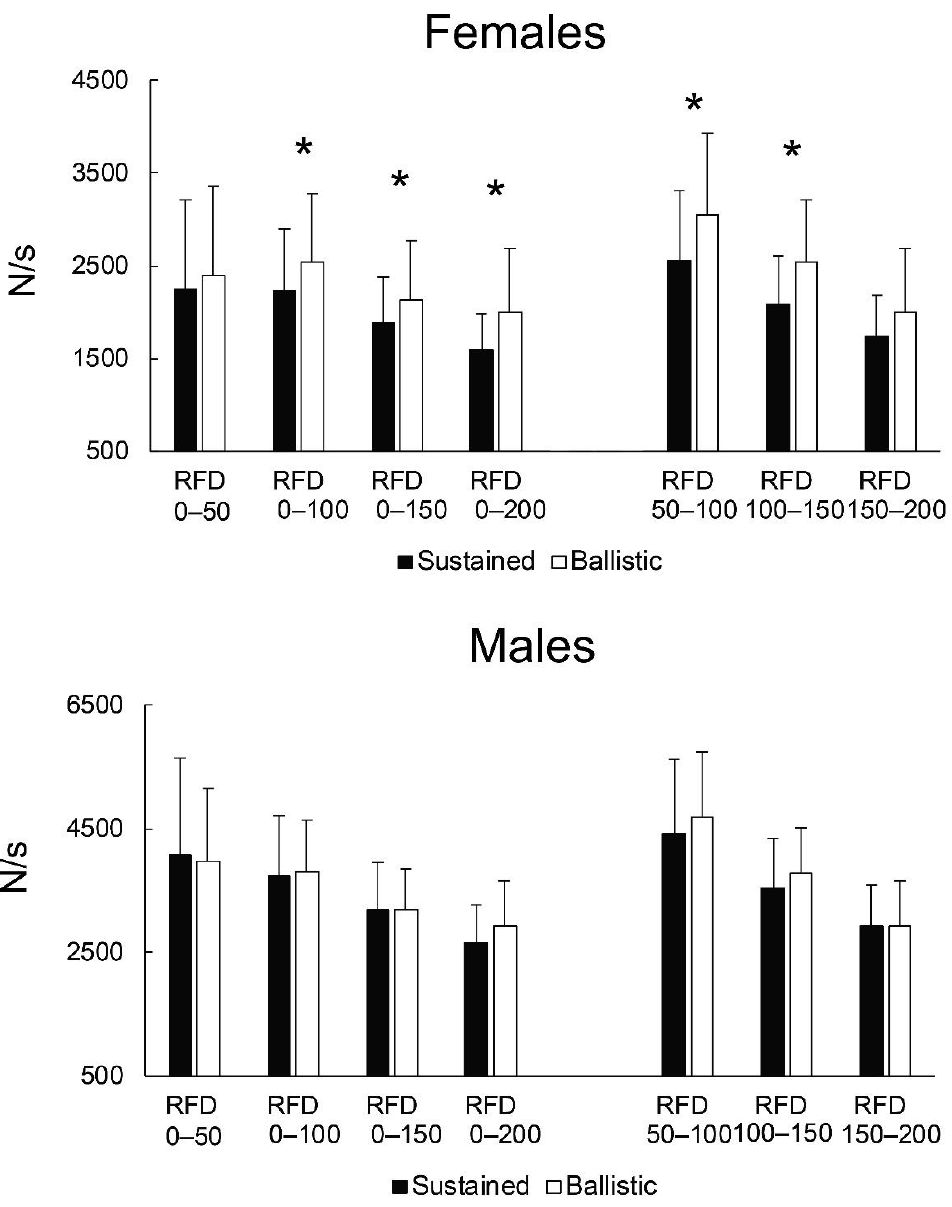
Figure 3. Comparison of RFD outcomes between explosive sustained and pulse contractions for the knee extension task across time intervals for females ( top graph ) and males ( bottom graph ). * indicates statistically significant pair-wise comparison.